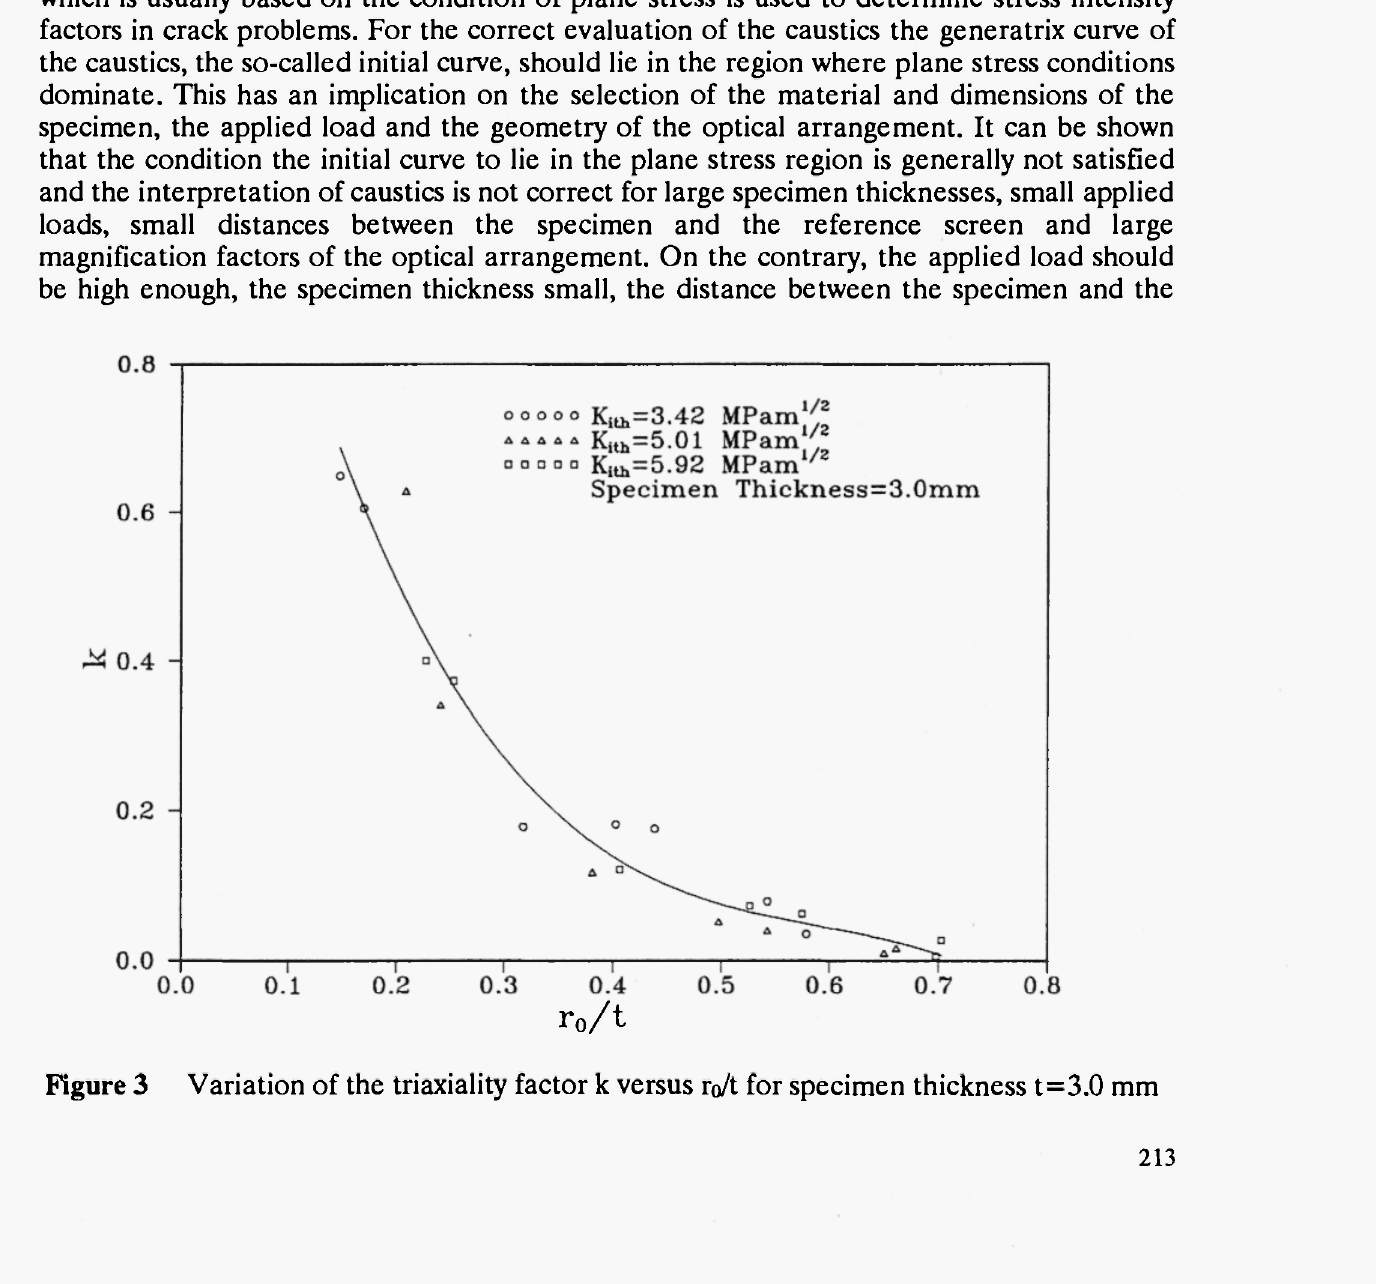
Figure 3 Variation of the triaxiality factor k versus ro/t for specimen thickness t=3.0